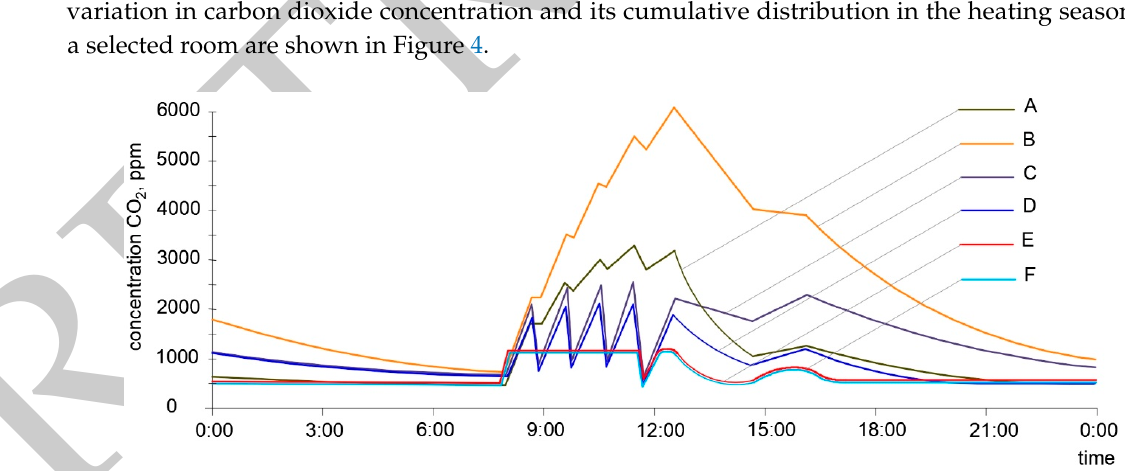
Figure 4. The course of variation in the concentration of carbon dioxide in the classroom (room located on the last level on the west side of the building) on one January day for the six variants